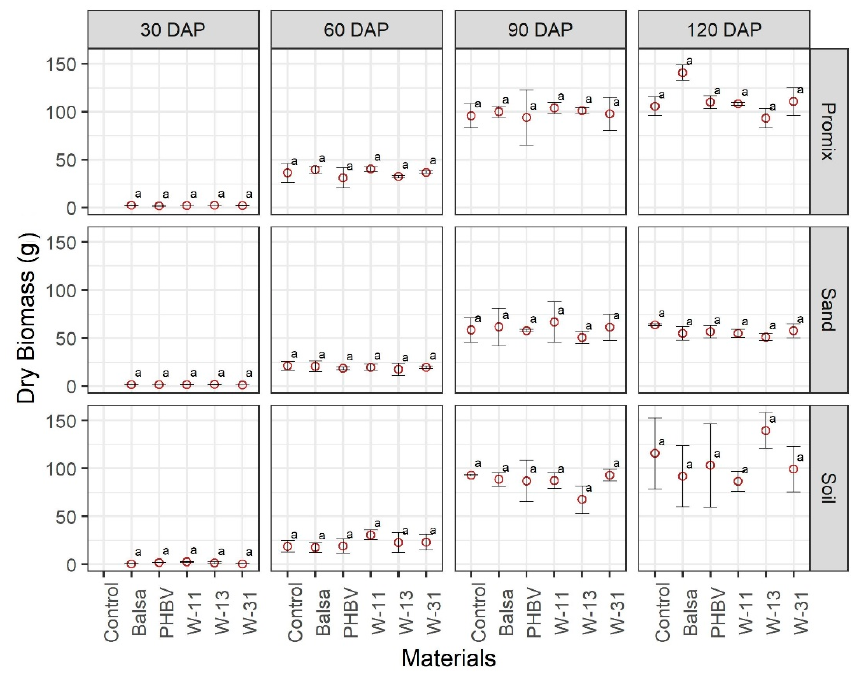
Figure 6. Comparison of maize dry biomass (g) in three growing media (Promix, sand, and soil) and four growth stages (30, 60, 90, and 120 days after transplanting (DAP)). Different lowercase letters indicate significant differences at α = 0.05, whereas same letters indicate no significant difference across compared treatments.